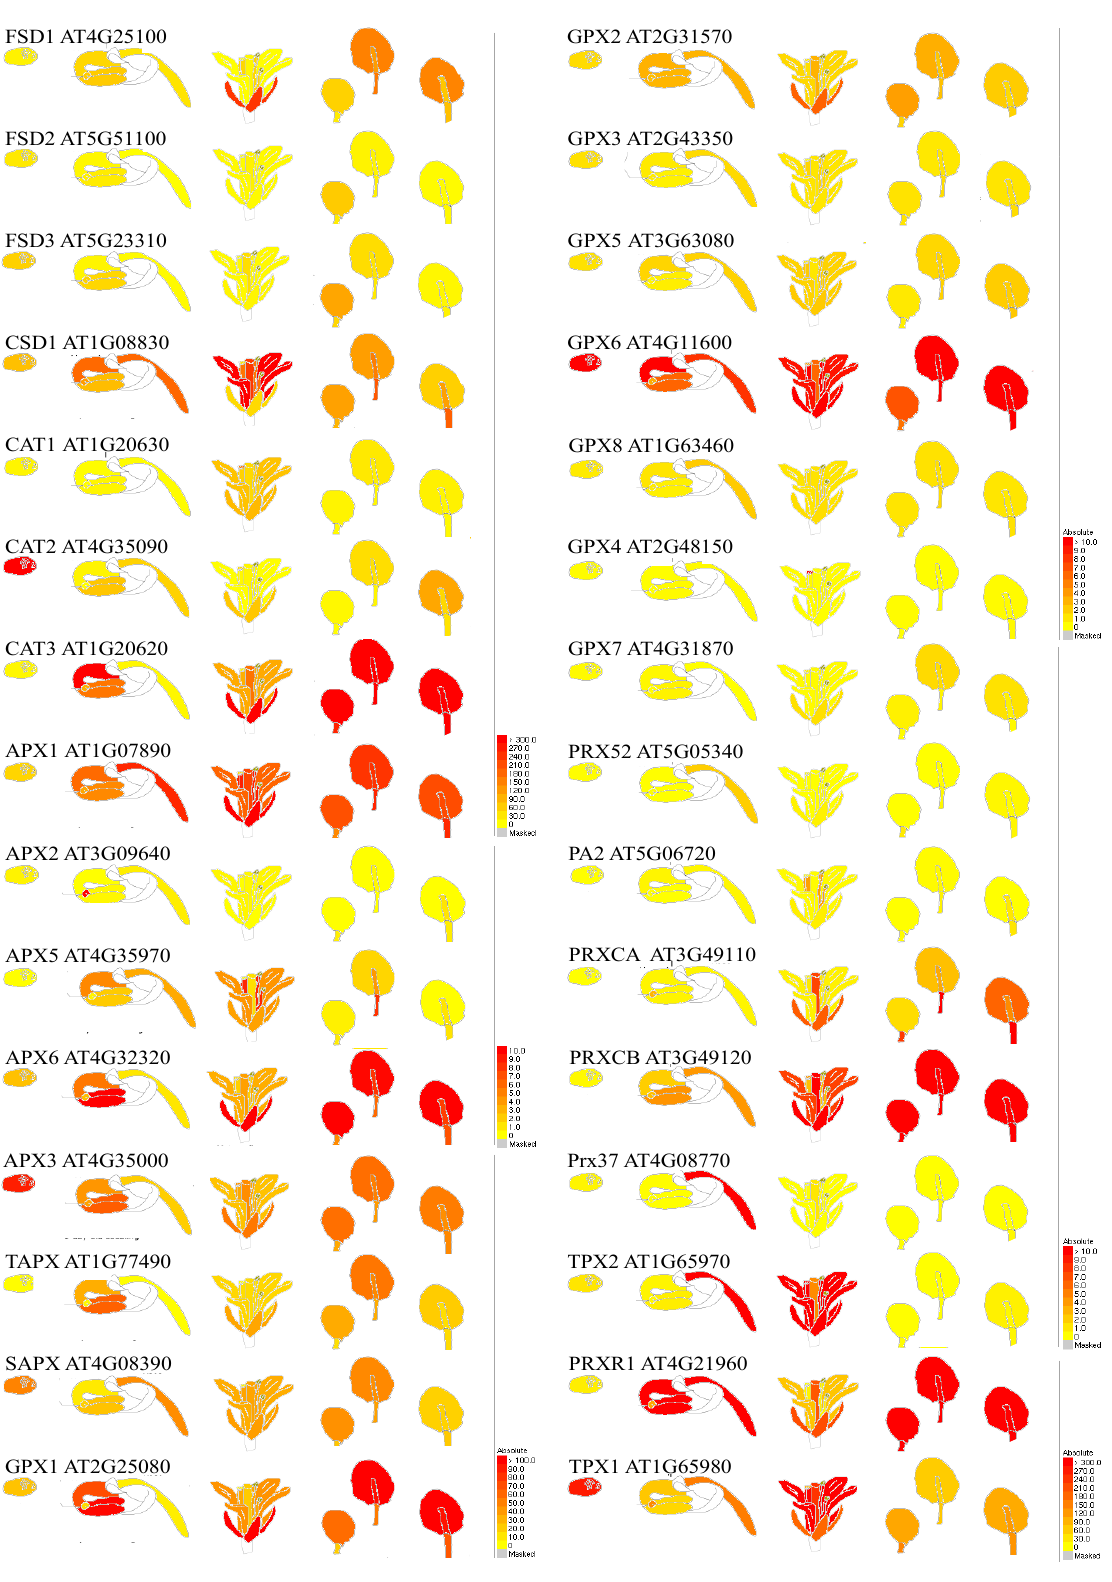
Figure 2. Developmental- and organ-dependent expression of genes coding superoxide dismutase, catalases, and peroxidases, based on Klepikova Arabidopsis Atlas eFP Browser at bar.utoronto.ca. Gene names and characteristics are provided in Table 2.